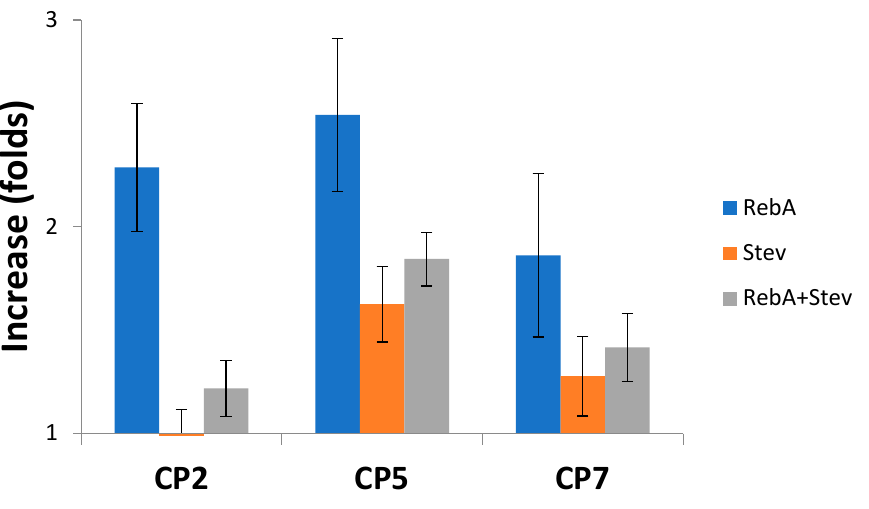
Figure 3. CP-induced changes in concentration of RebA, Stev and total concentration of RebA and Stev (RebA+Stev) in stevia leaves compared to control. Means ± SEM are presented (n = 7). 2.4. Effects on Total Phenolic Content, Flavonoid Content and Antioxidant Activity